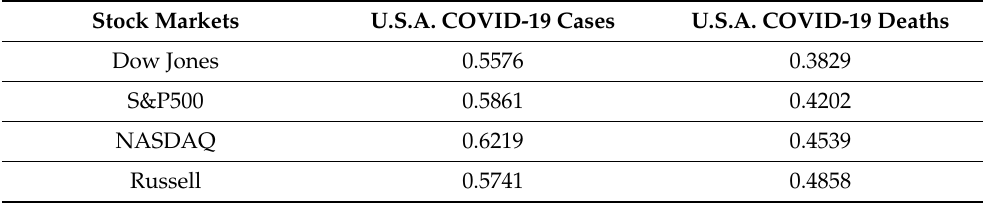
Table 4. Correlation matrix for stock markets and U.S.A. COVID-19 cases and